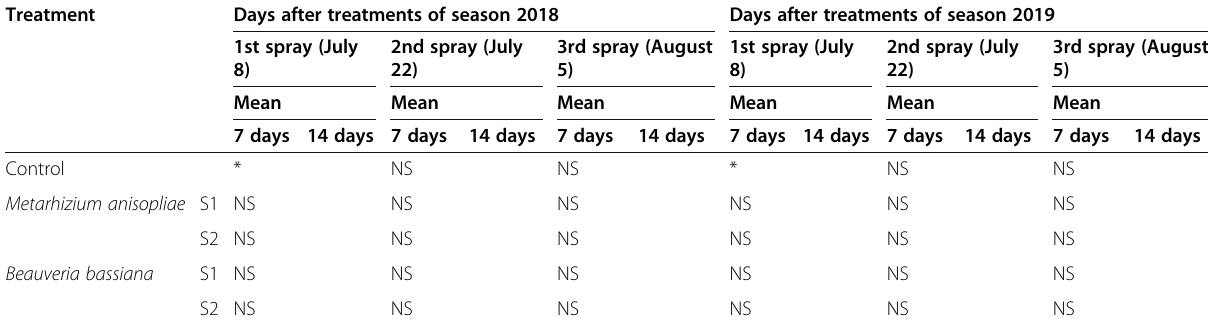
Table 3 T -test comparison between the mean infestations of Earias insulana after using the two fungal after 7 and 14 days at each treatment and control in 2018 and 2019 seasons